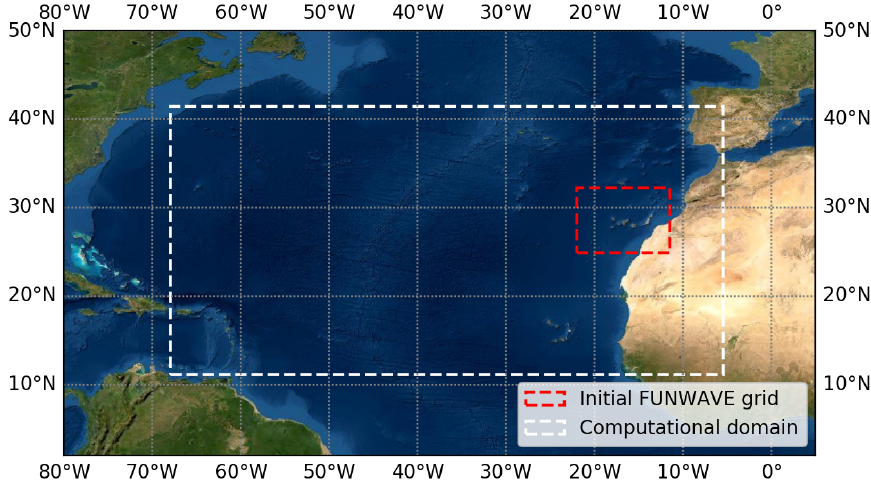
Figure 2. Computational domains. The red area represents the first 20 min of FUNWAVE simulation over a 500 m grid resolution. The white area delimits the FUNWAVE domain for the trans-Atlantic propagation with 1 arc degree resolution, as well as the SCHISM grid domain where the hotstart takes place at